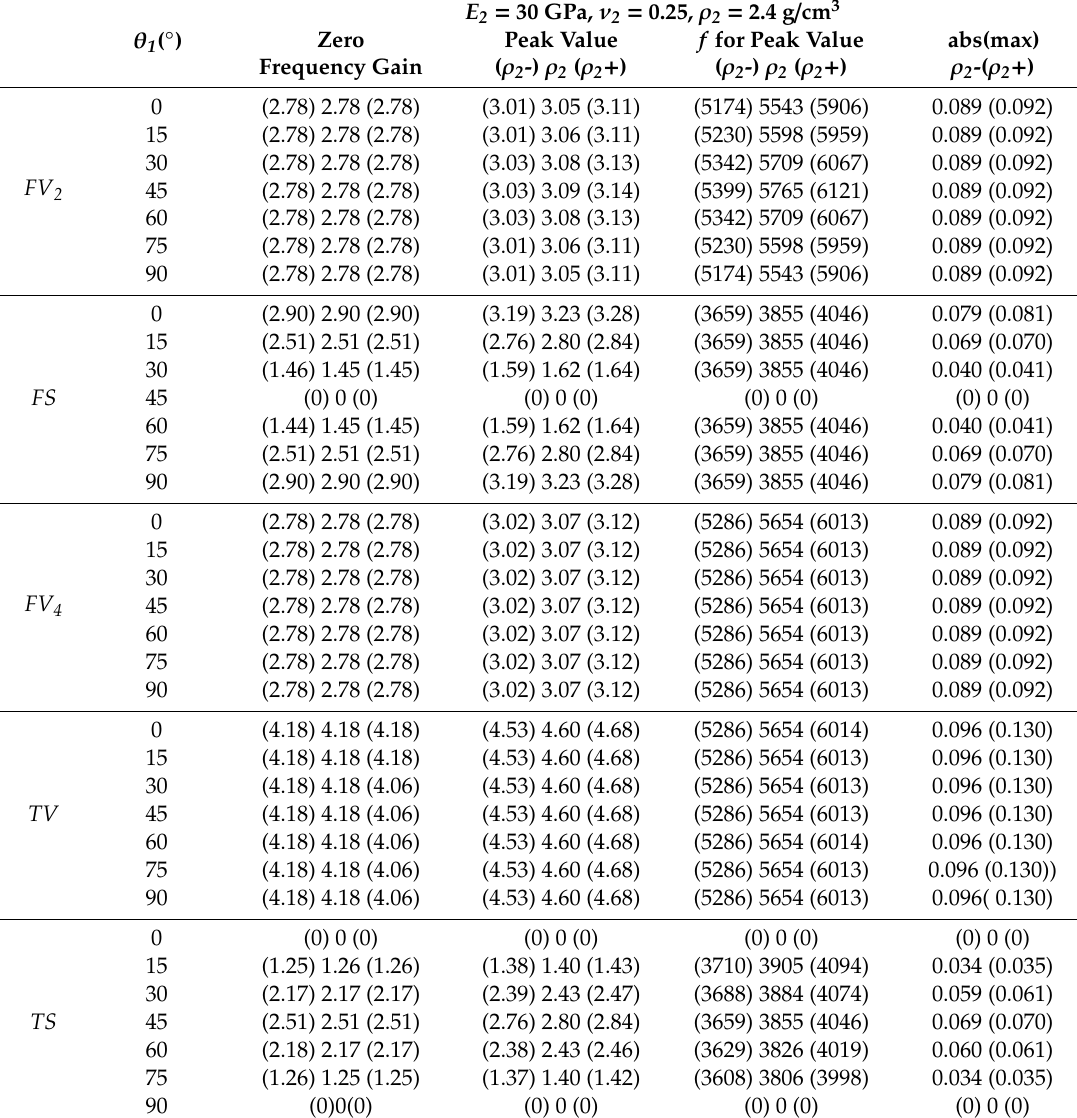
Table 4. Influence of the expansive grout density on theoretical amplitude spectrum of gauge combinations FV 2 , FV 4 , FS, TV and TS for the incident P